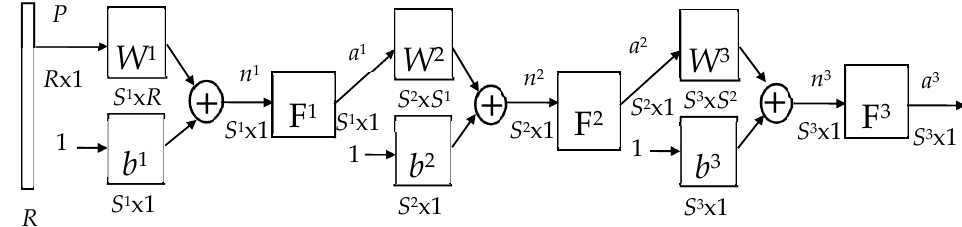
Figure 10. Flow chart of the multylaer neural network.